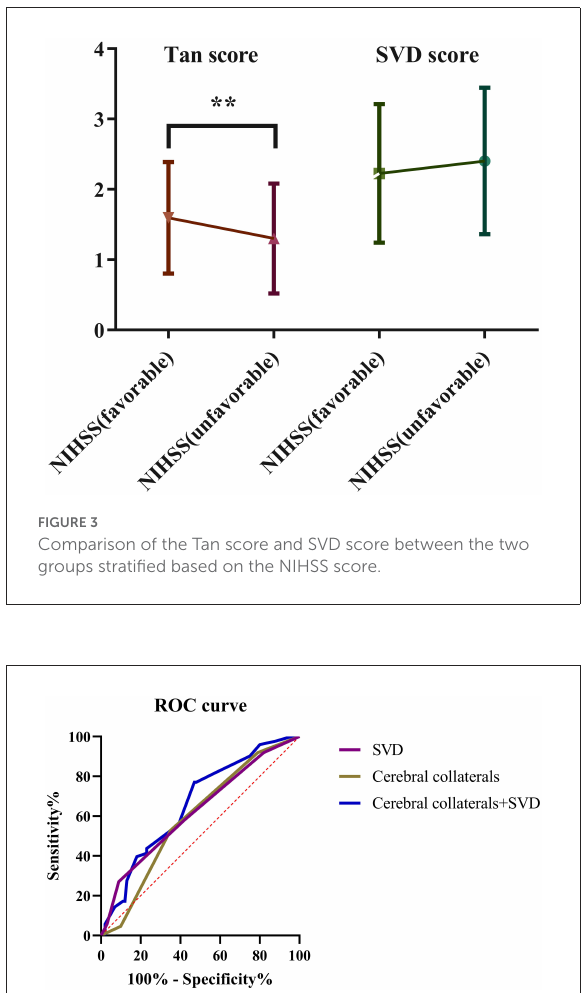
TABLE 3 The multivariate logistic regression analysis of Model 2.